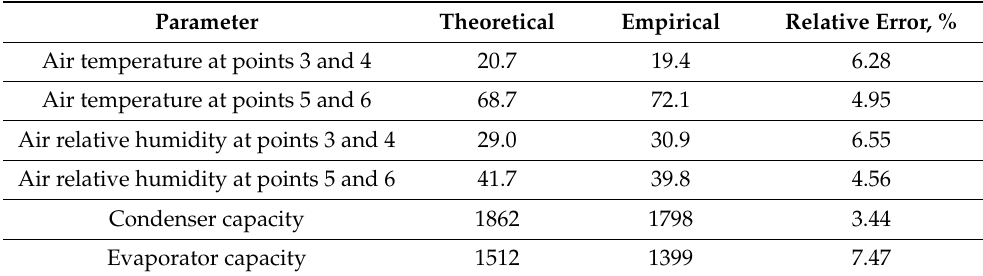
Table 8. Comparison of theoretical and empirical